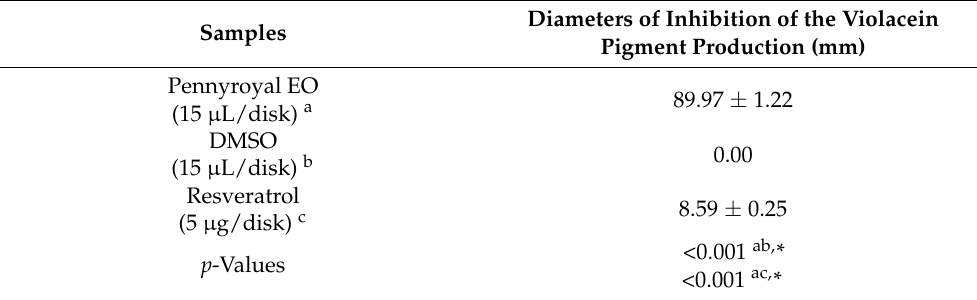
Table 5. Anti-quorum-sensing activity of pennyroyal EO.